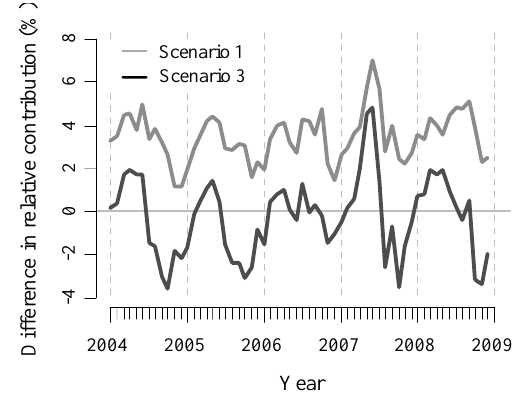
Fig. 12. Difference in relative contribution of the WWTPs to the total river flow at the outlet station of the Grote Nete catchment (% difference in monthly mean total flow) between the model-based and empirical analysis results (rainfall scenario 1 and 3). The dif- ference in contribution increases during flow recession periods.